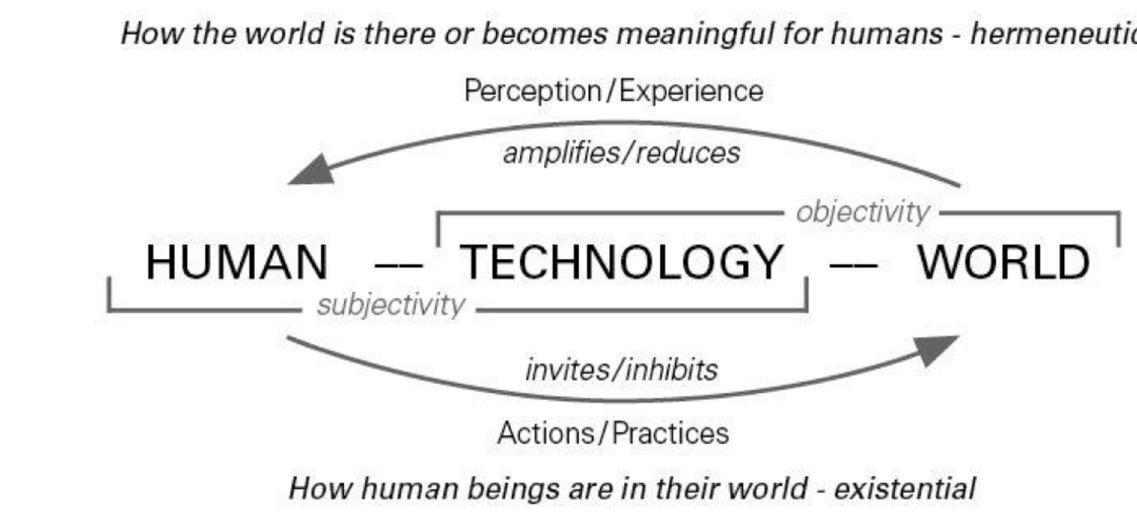
FIGURE 2 | Technological mediation (Hauser et al.,